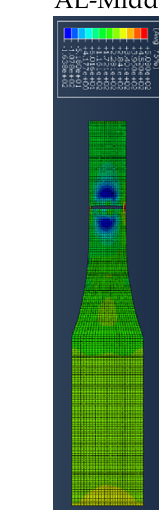
Figure 8. Stress distribution of the four top layers of laminate A at 2.8 mm displacement.